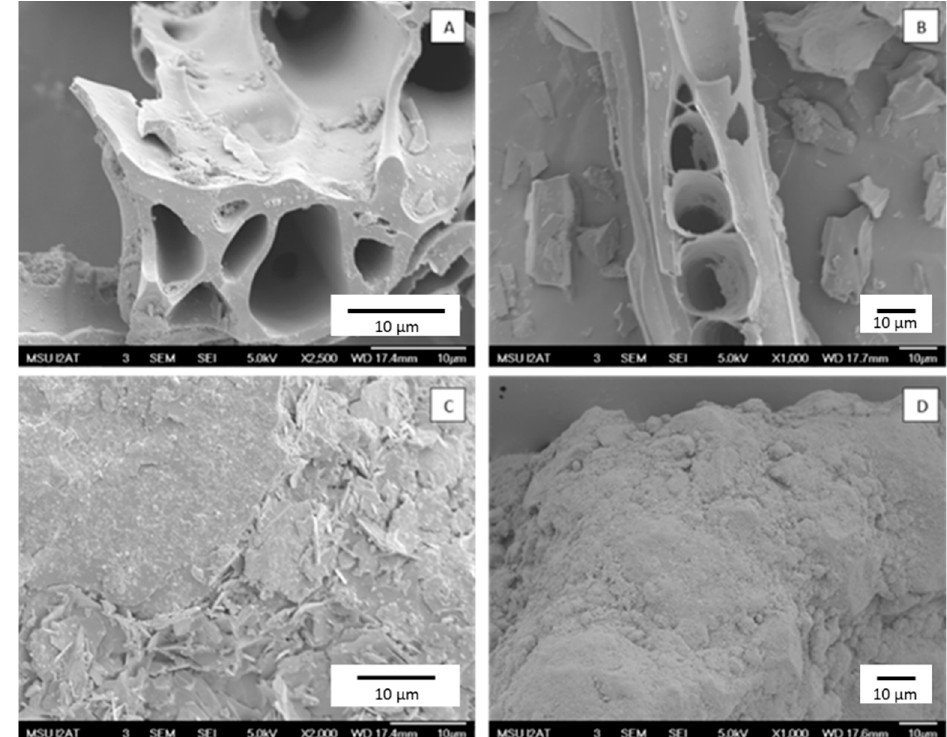
Figure 3. Images ( A , B ) are SEM images of biochar A-before and B-after the adsorption of phosphate. Images ( C , D ) are SEM images of slag A-before and B-after the adsorption of phosphate [pH = 5.0; adsorbent concentration = 0.002 g/mL; 150 mg/L PO 43 − solution; shaking time 24 h]. EDX confirms phosphate adsorption from an aqueous phosphate solution [27,28].